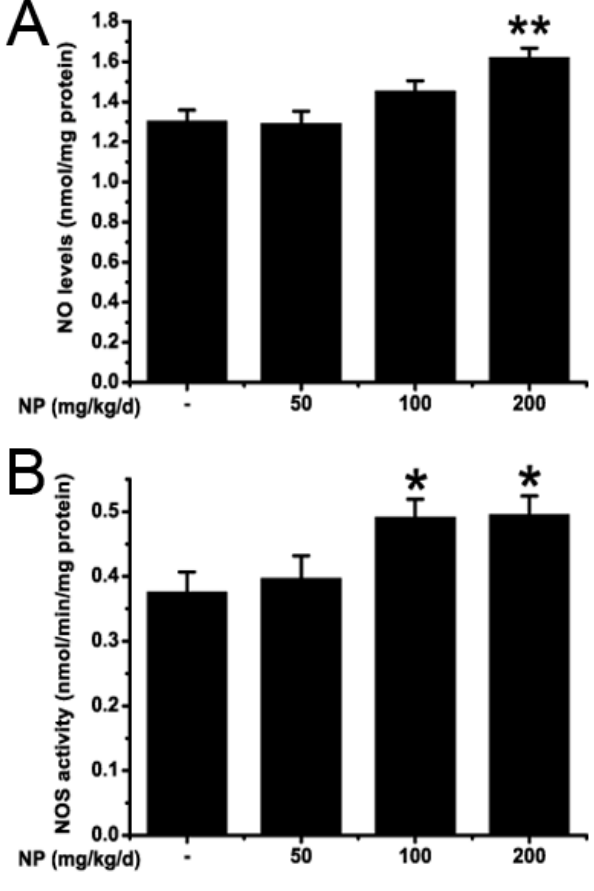
Figure 1. The effect of NP on NO level (A) and NOS activity (B) in mouse brain. Values are expressed as mean ± S.E.M. (n = 9). *P < 0.05; **P < 0.01 vs. the vehicle